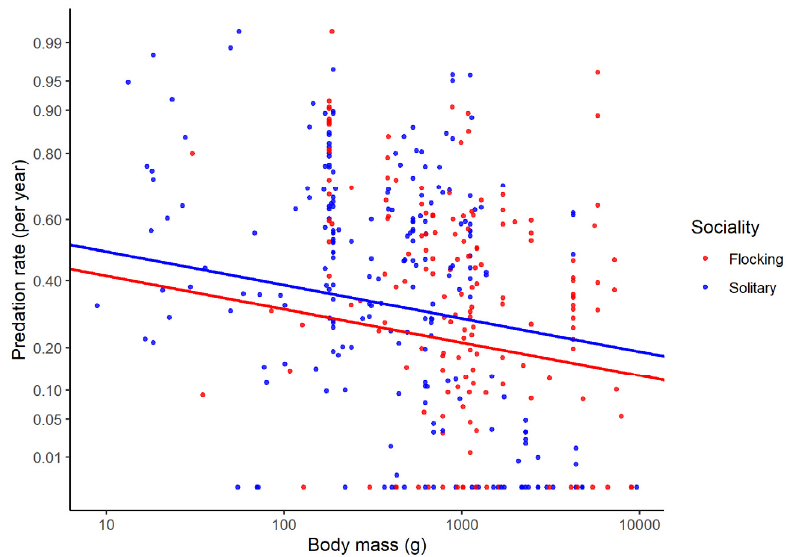
Figure 2. Predation rates expressed on a yearly basis as a function of adult body mass for solitary and flocking species of birds. The regression lines were obtained from a phylogenetic linear mixed model. Predation rate is shown in arc-sine square-root scale, and body mass in log 10 scale.